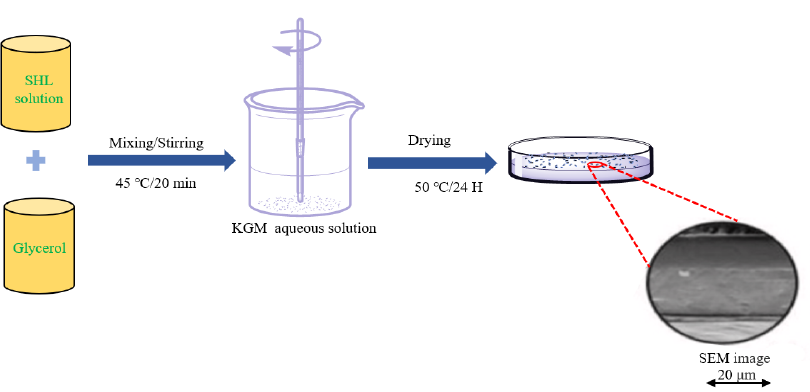
Figure 1. Scheme of the preparation of KGM/shellac films via casting (Adopted from Ni et al.) [ 71 ]. A shellac (SHL) solution and glycerol were added to the prepared KGM dispersion and stirred at 350 rpm for 20 min at 45 °C. Then, the mixed solution was slowly poured into a glass dish and 350 rpm for 20 min at 45 ◦ C. Then, the mixed solution was slowly poured into a glass dish and placed placed in a vacuum drying oven at 50 °C for one day. in a vacuum drying oven at 50 ◦ C for one